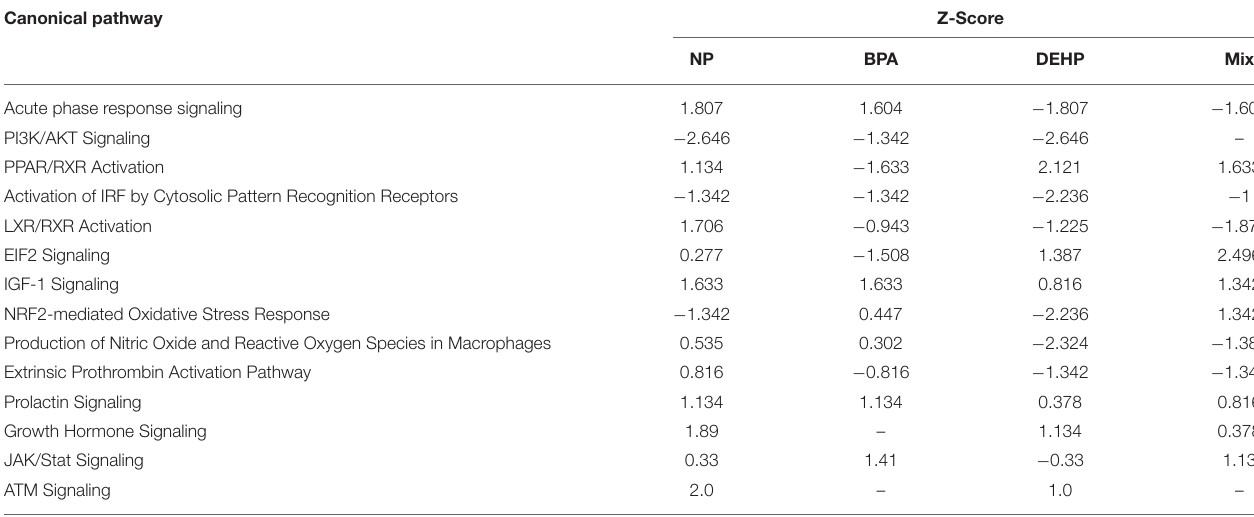
TABLE 3 | Canonical pathways and biological processes associated with significantly altered transcripts in fathead minnow liver after 21 days exposure to NP, BPA, DEHP and the mixture of the three chemicals using Ingenuity Pathways Analysis (IPA) and Fisher exact test ( P < 0.05). Canonical pathway Z-Score NP BPA